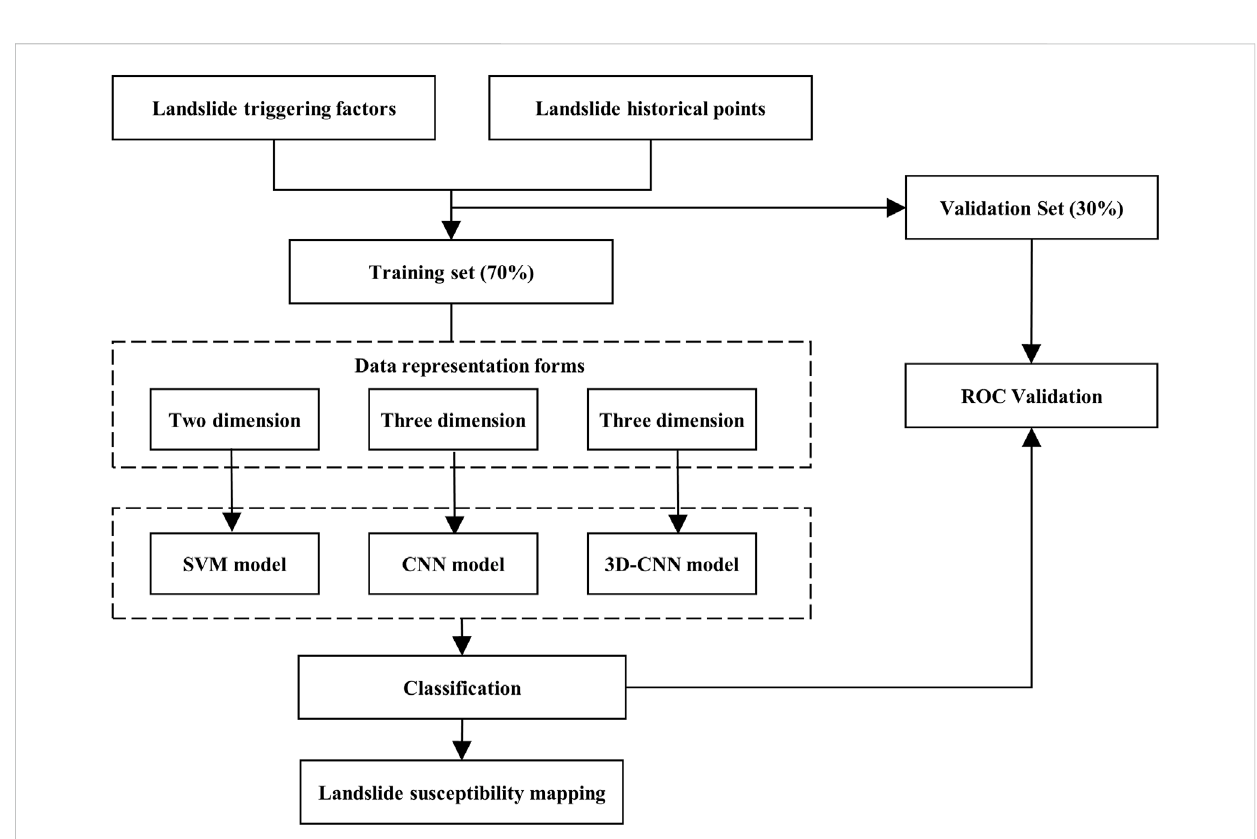
FIGURE 3 Flowchart of the present